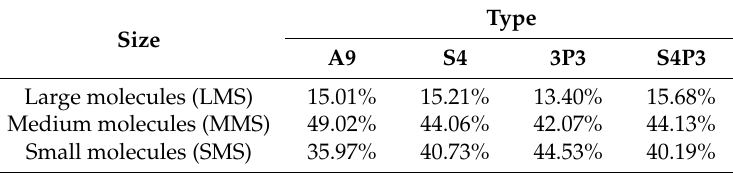
Figure 9. Gel permeation chromatography (GPC) of asphalt before aging. Table 5. Molecular weight distribution of di ff erent asphalt